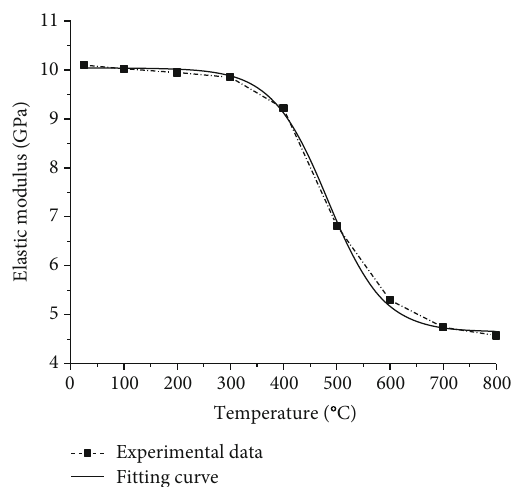
Figure 6: Elastic modulus of the heat-treated sandstone.